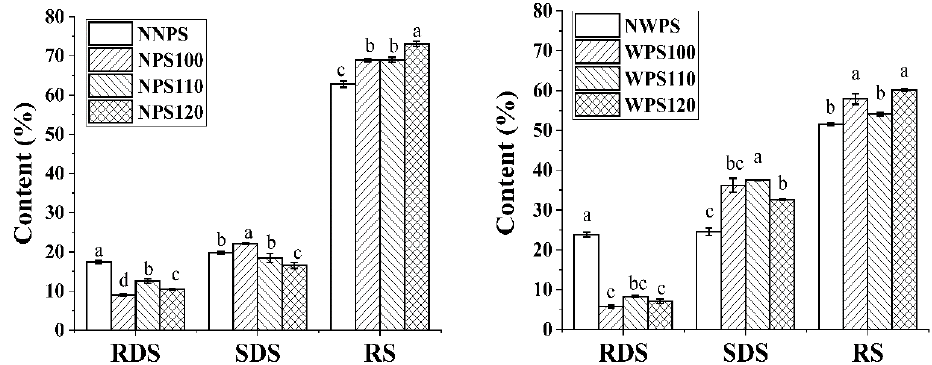
Figure 7. Digestibility of the samples. Different letters in a column signify significant differences ( p < 0.05). ( p <